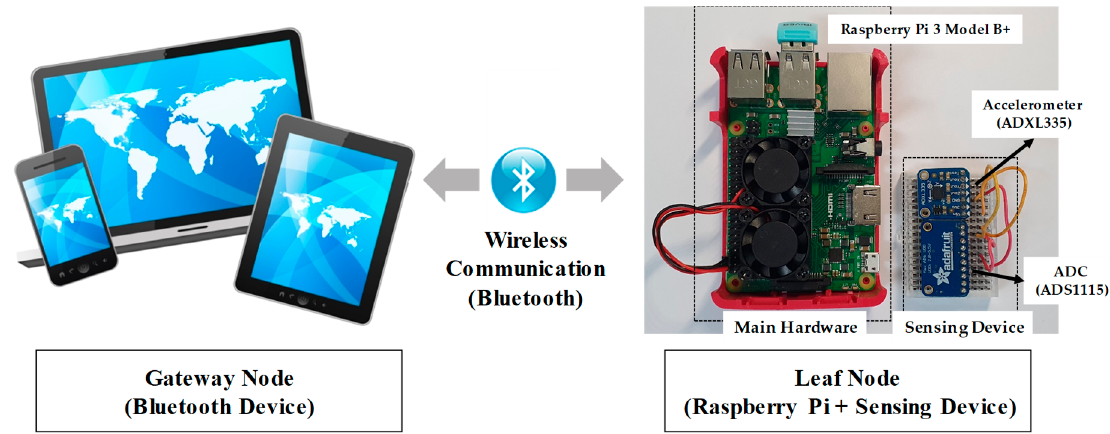
Figure 2. Design of wireless automated real-time cable serviceability assessment system .